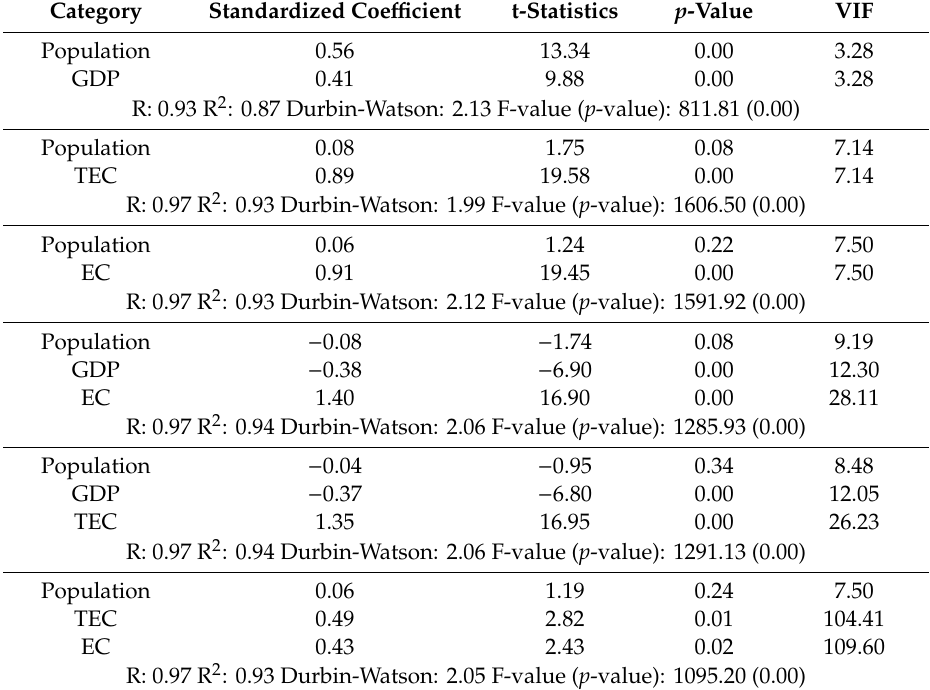
Table 3. Results of di ff erent multiple regression models with di ff erent combinations of independent variables (decomposed variables of the Kaya identity) and F Foss as a dependent variable.